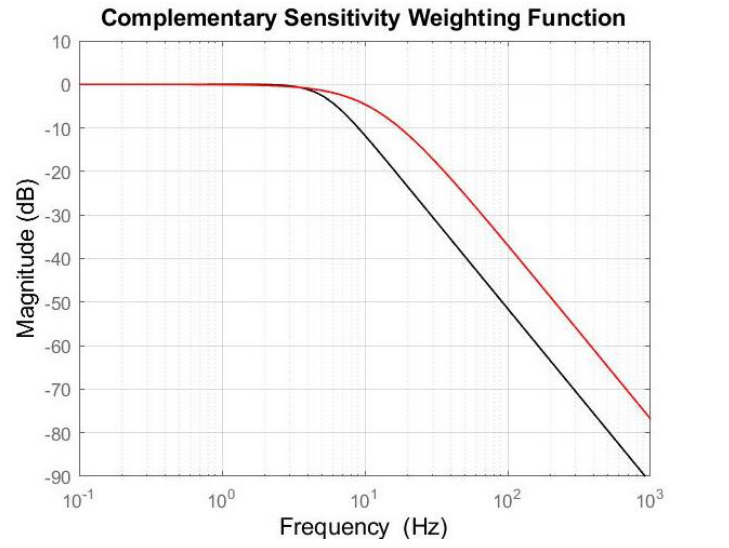
Figure 10. T ( s ) (black line) and W t ( s ) (red